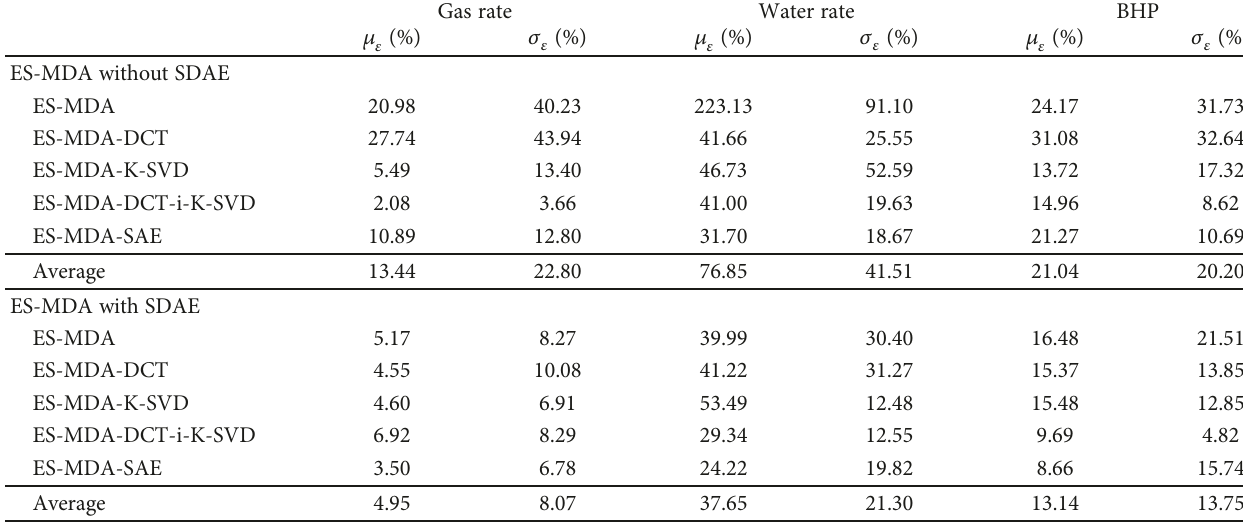
Table 7: Statistical parameters of history matching errors for gas rate, water rate, and BHP (only for the wells installed in the sand formation). μ σ ε refer to the mean and standard deviation of errors, respectively. ε and